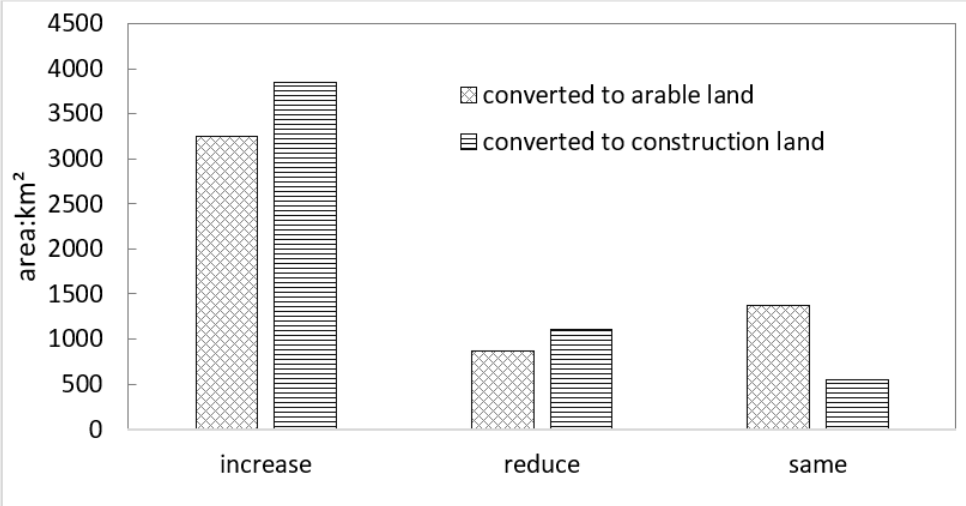
Figure 8. Conversion of cultivated land and construction land and changes in the ecological risk. 3.2.2. Spatiotemporal Analysis of Landscape Ecological Risk In ArcGIS, kriging interpolation was carried out on the landscape ecological risk in- dex during the three phases of development of the community, and maps of the spatial distribution of the landscape ecological risk in the study area in 2000, 2010, and 2020 were obtained (Figure 9). According to the interpolation results, the ecological risk values were divided into five categories using the natural breakpoint method and taking the actual